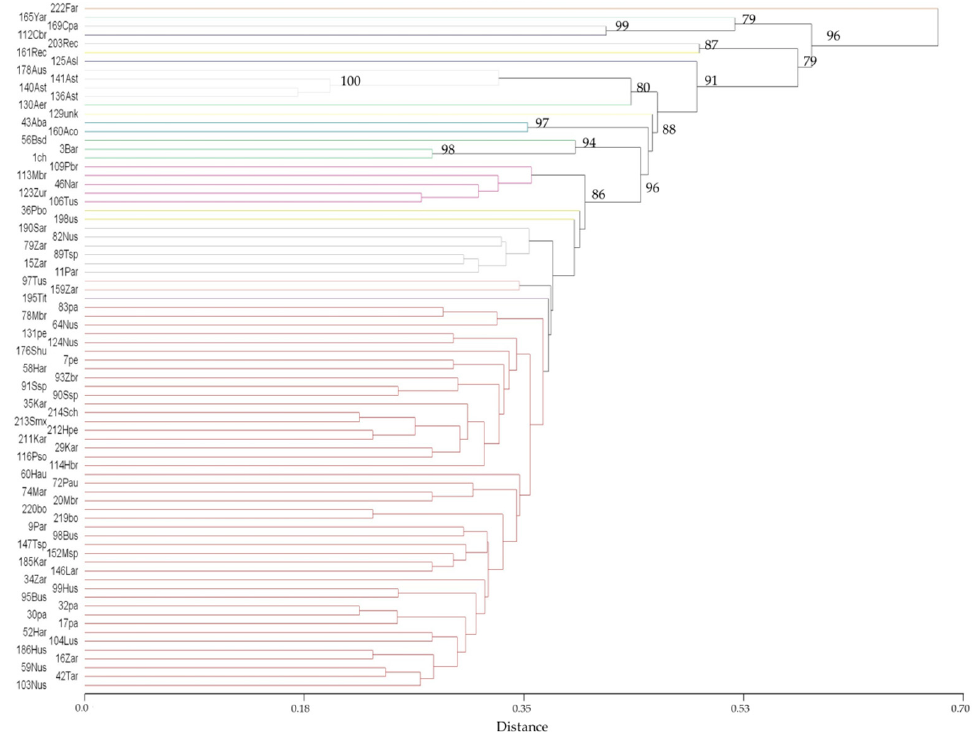
Figure 15. Hierarchical cluster dendrogram of 78 Cucurbita accessions for SRAP markers polymorphisms. Unbiased p -values for multiscale bootstrap resampling are showed in some branching. For entries, a tripartite abbreviation code was used, in which the number is a household accession code (see supplementary Table S1 for details); uppercase letter refers to species other than C. maxima or cultivar-group in C. maxima , F ( C. ficifolia ), Y ( C. argyrosperma ), C ( C. moschata ), R ( C. ecuadorensis ), A (ssp. andreana ), B (Buttercup), P (Plomo), M (Moranga), Z (Zapallito), T (Turban), S (Show), H (Hubbard), K (Zipinka), L (Banana), N (Nugget). When C. maxima accessions could not be assigned to any cultivar-group, uppercase letter is missing. The rest of the lower case letters in the code refers to country of origin us (USA), ar (Argentina), pe (Peru), br (Brazil), ch (Chile), bo (Bolivia), pa (Paraguay), ur (Uruguay), ec (Ecuador), mx (Mexico), sp (Spain), it (Italy), hu (Hungary), au (Australia), so (South Africa) and unk (not specified in passport data). For Argentinian entries of ssp. Andreana , lowercase letters indicate Province of origin, st (Santiago del Estero), co (C ó rdoba), er (Entre R í os), sl (San Luis) and ba (Buenos